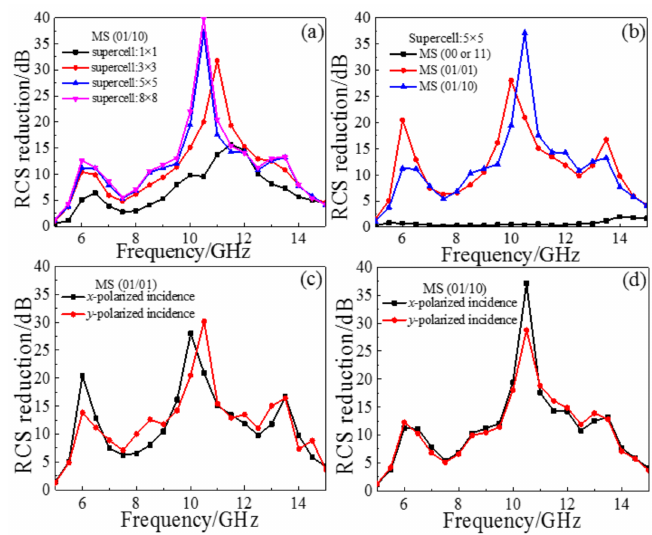
Figure 6. Simulated results of a series of regular coding MSs: ( a ) RCS reduction of 01/10 coding MS for different super-cell combinations; ( b ) RCS reduction of the different regular coding MS with 5 × 5 super-cell; ( c ) RCS reduction of the 01/01 coding MS for normal x - and y -polarized incident waves; ( d ) RCS reduction of the 01/10 coding MS for normal incident x - and y -polarized waves.